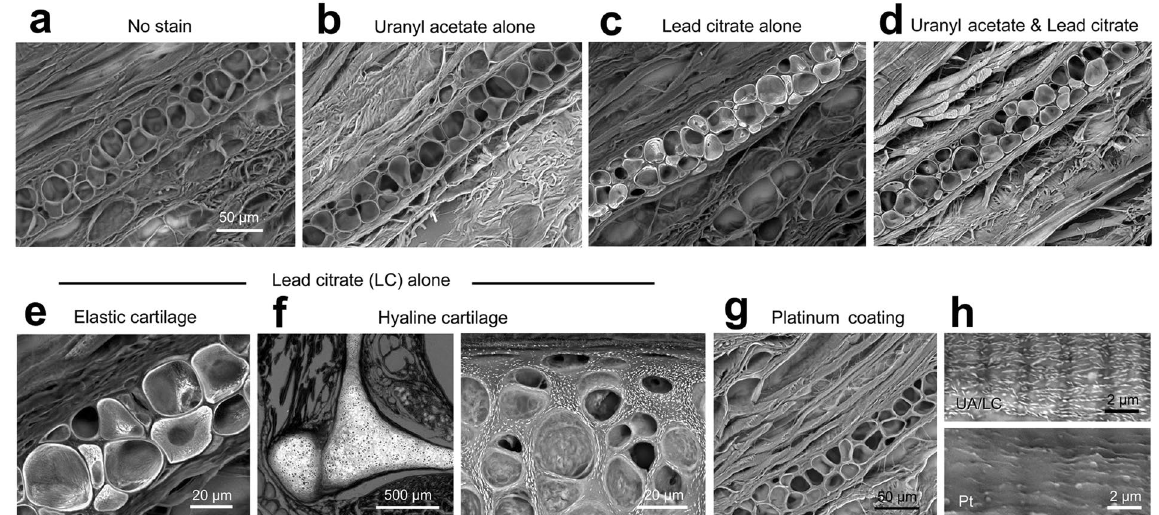
Figure 3. Preliminary examinations to determine the stainability of 30 µ m paraffin sections. ( a – e , g , h ) Rat auricle and ( f ) larynx. ( a ) No stain. ( b ) 1% uranyl acetate in 70% methanol (UA) alone. ( c ) Reynolds’ lead citrate solution (LC) alone. ( d ) UA and LC. ( e , f ) High-power view of elastic cartilage ( e ), and hyaline cartilage ( f ) in larynx stained with LC alone. Note the remarkable LC-stainability of the cartilage, as shown in the high-power view of hyaline matrix (right in f ). ( g ) Platinum coating. ( h ) Comparison between UA/LC staining (upper) and platinum coating (lower) on skeletal muscle fibre. The skeletal muscle striation is significantly masked by the platinum coating.